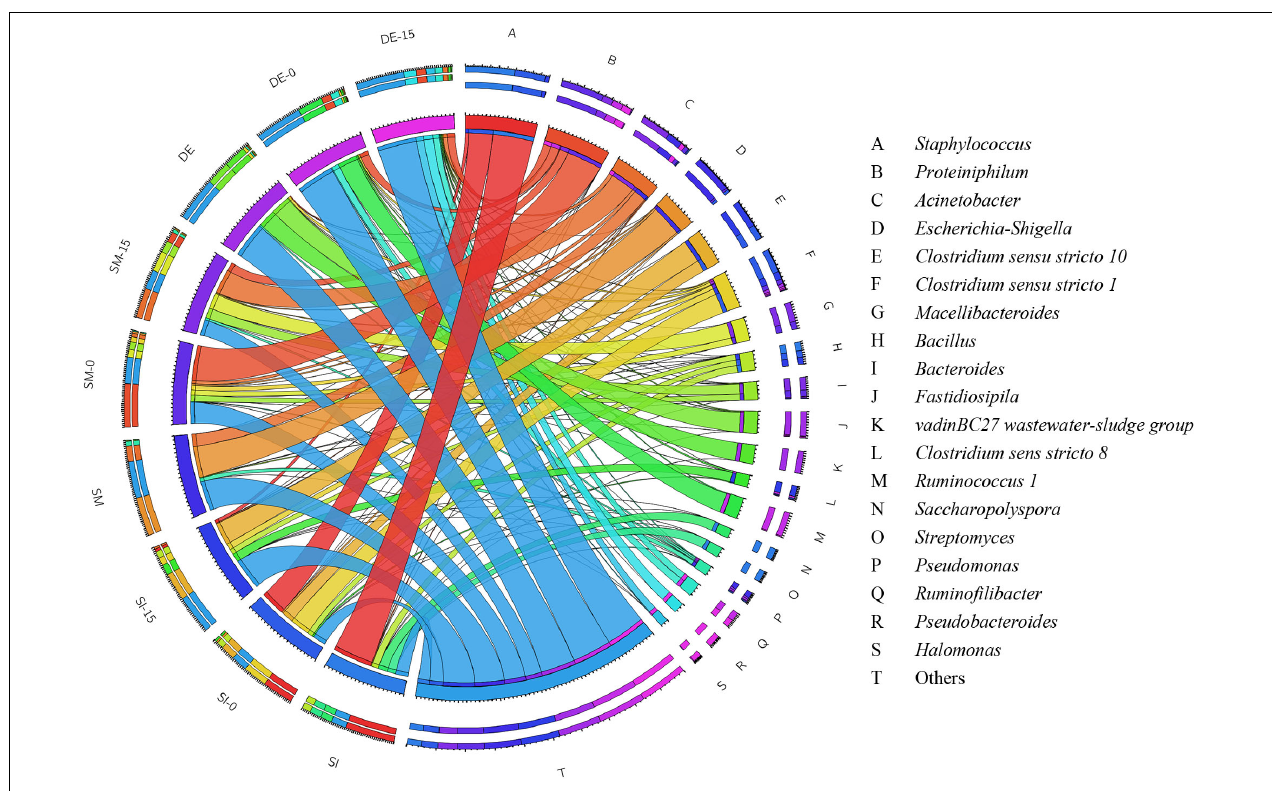
FIGURE 5 | The relative abundance of bacteria in the SI, SM, DE, and pretreated PW at the genus level.